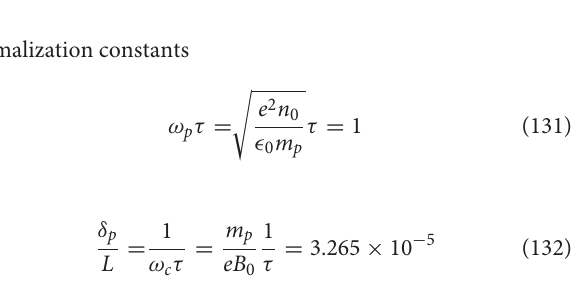
FIGURE 9 | Double rarefaction waves problem with 5 N -moment model on left of model interface and continuum kinetic model with BGK operator on right of model interface at t 0.15 on x [0,1] subject to direct variable translation matching. The top case has the model interface at x = ∈ interface at x 0.667. Black dashed lines are the analytic solution to the fluid Riemann problem [ =